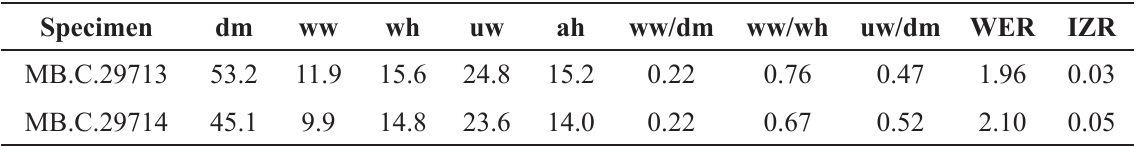
Table 3. Conch dimensions (partly estimated) and ratios of selected specimens of Shevyrevites nodosus Shevyrev, 1965 from Baghuk